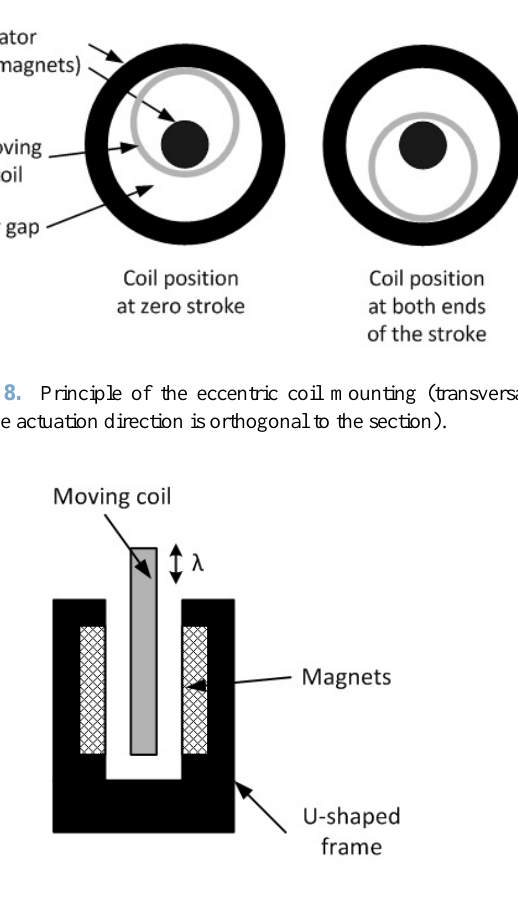
Figure 9. Transversal section of the linear EC actuator (the actua- tion direction is orthogonal to the